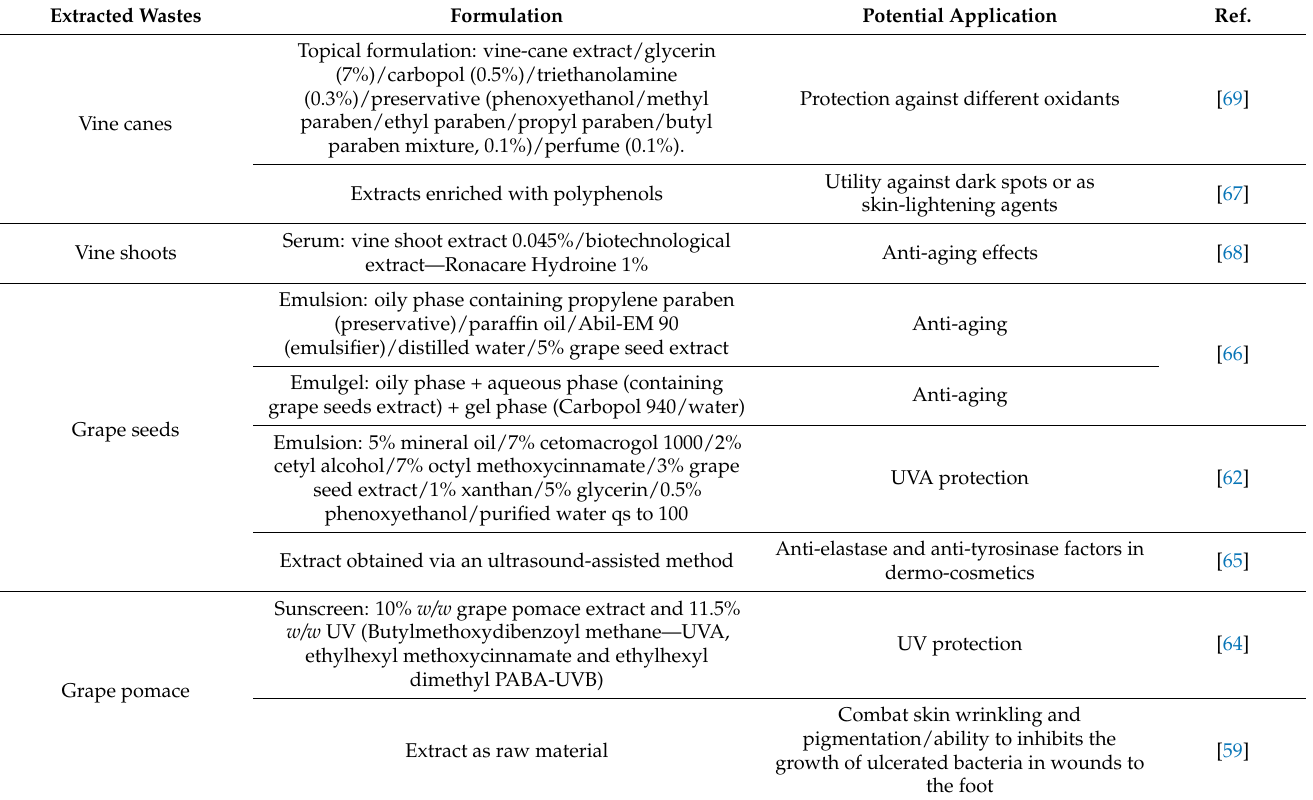
Table 2. Some examples of grapevine wastes application in cosmetic formulations. Formulation Potential Application